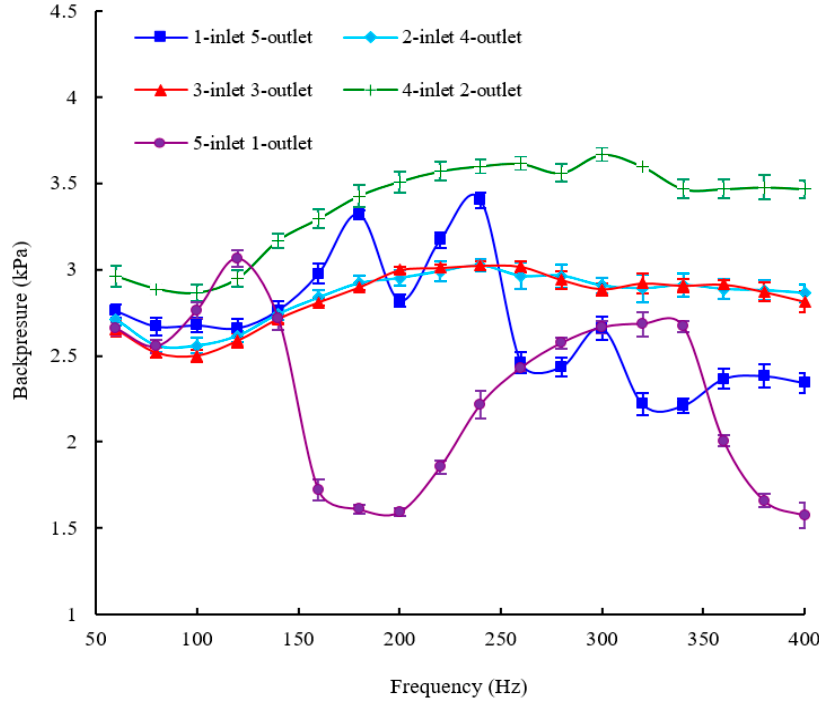
Figure 6. The backpressure versus frequency characteristics of the pump with different configurations of inlet valves and outlet valves.